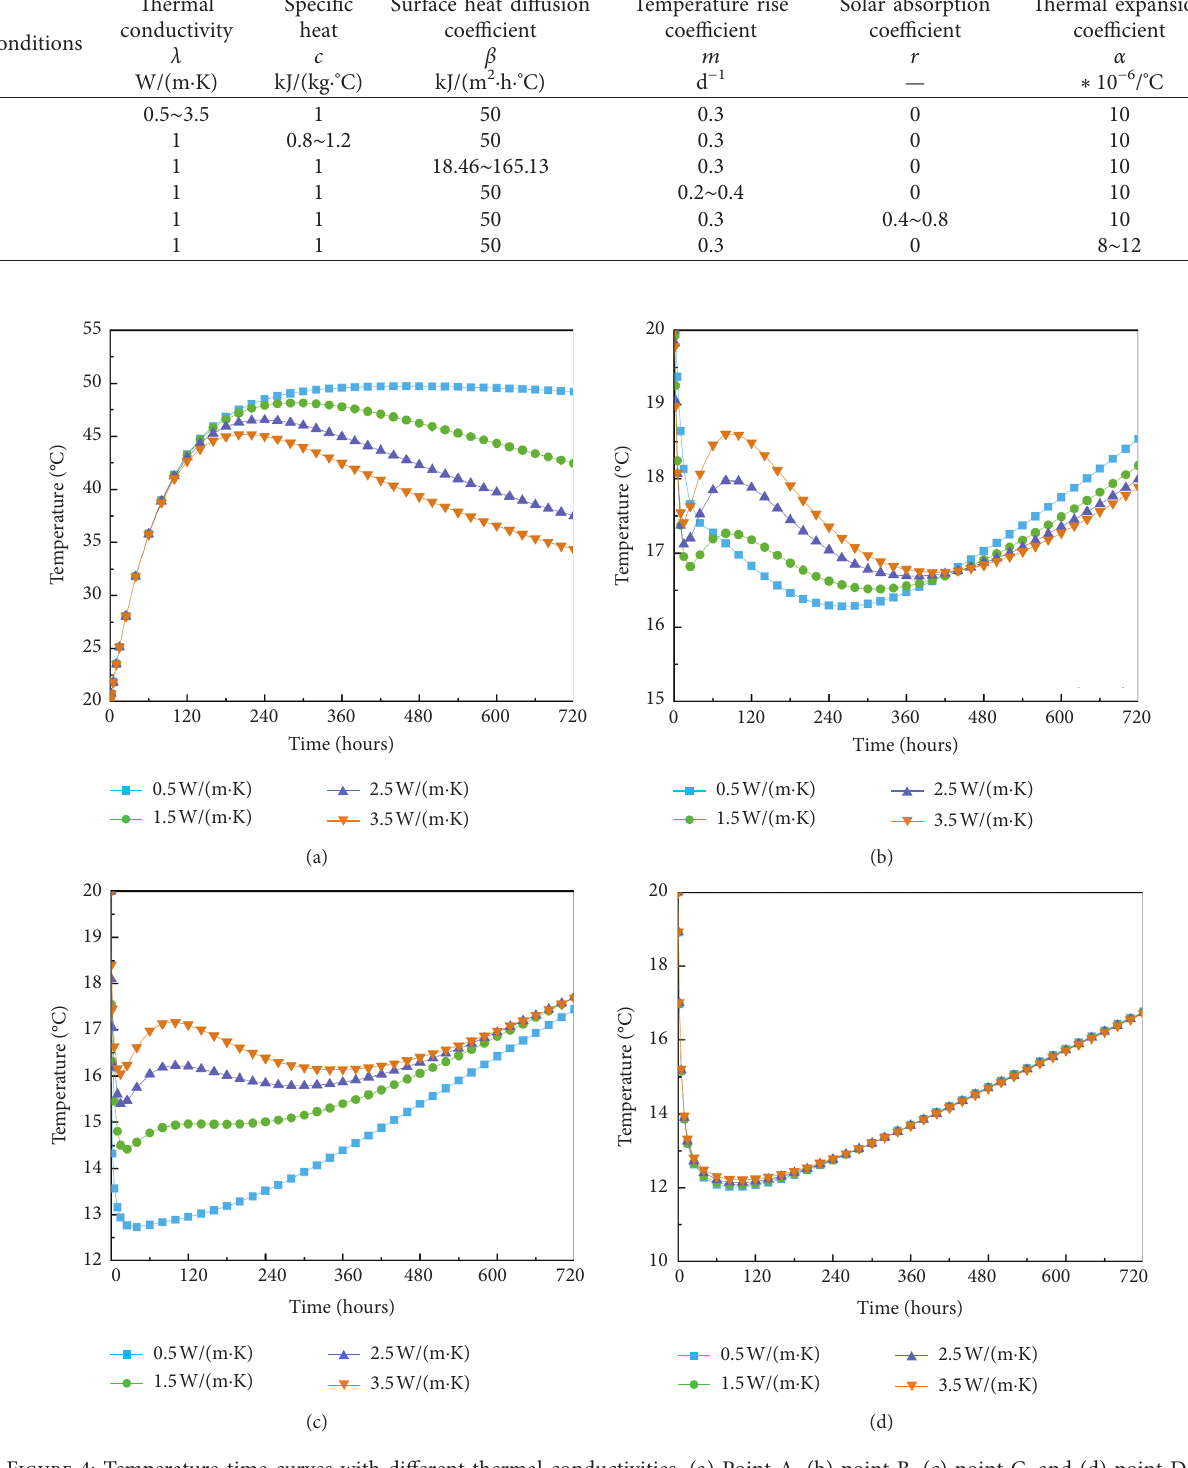
Figure 4: Temperature-time curves with different thermal conductivities. (a) Point A, (b) point B, (c) point C, and (d) point